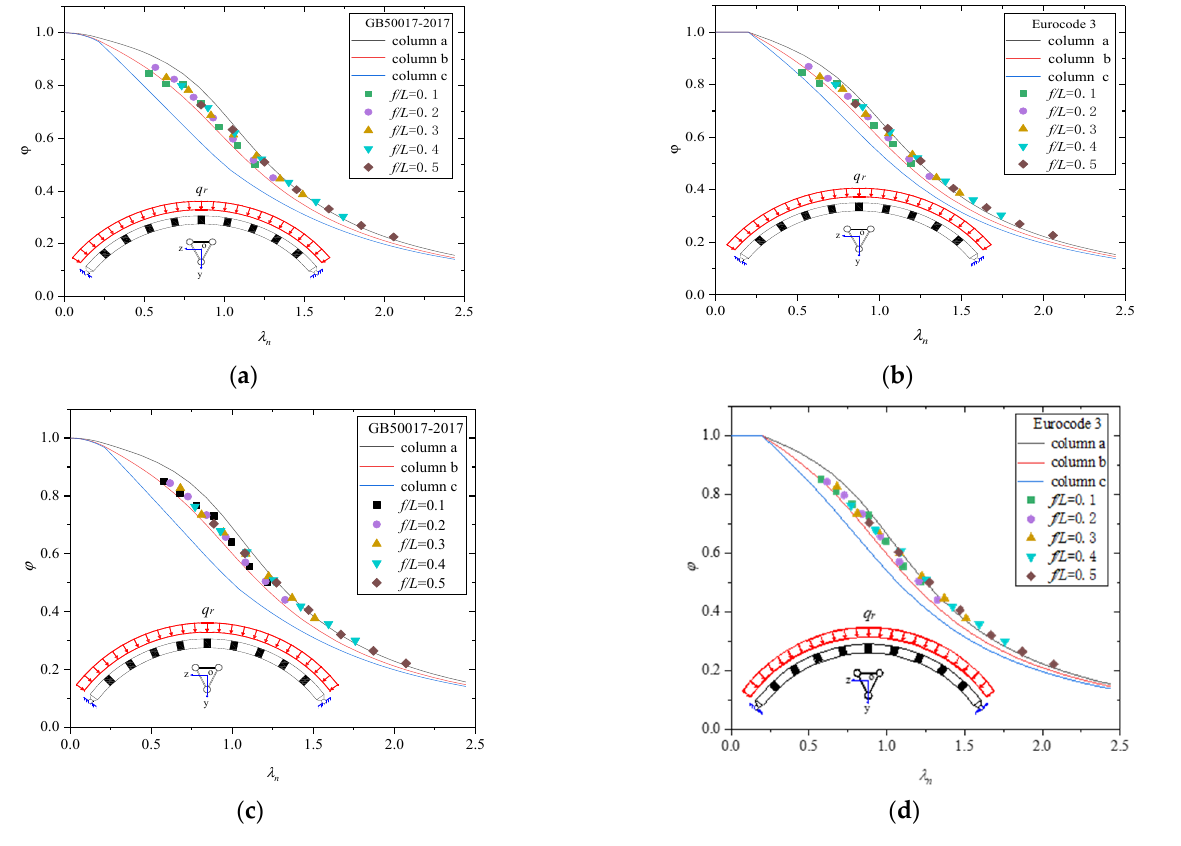
Figure 13. 𝜑 − 𝜆 (cid:3041) curve of the arch under FSURL: ( a ) results of FE and GB50017-2017 ( 𝐿 (cid:2868) = 𝐻 ); ( b ) Figure 13. ϕ − λ n curve of the arch under FSURL: ( a ) results of FE and GB50017-2017 ( L 0 = H ); results of FE and Eurocode 3 ( 𝐿 (cid:2868) = 𝐻 ) ; ( c ) results of FE and GB50017-2017 ( 𝐿 (cid:2868) = 1.5 𝐻 ); ( d ) results of ( b ) results of FE and Eurocode 3 ( L 0 = H ); ( c ) results of FE and GB50017-2017 ( L 0 = 1.5 H ); ( d ) results FE and Eurocode 3 ( 𝐿 (cid:2868) = 1.5 𝐻 ). of FE and Eurocode 3 ( L 0 = 1.5 H